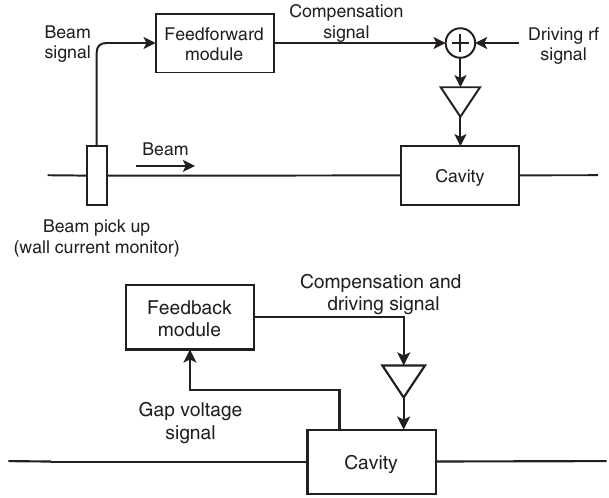
FIG. 1. Conceptual diagrams of (top) the rf feedforward method and (bottom) the voltage